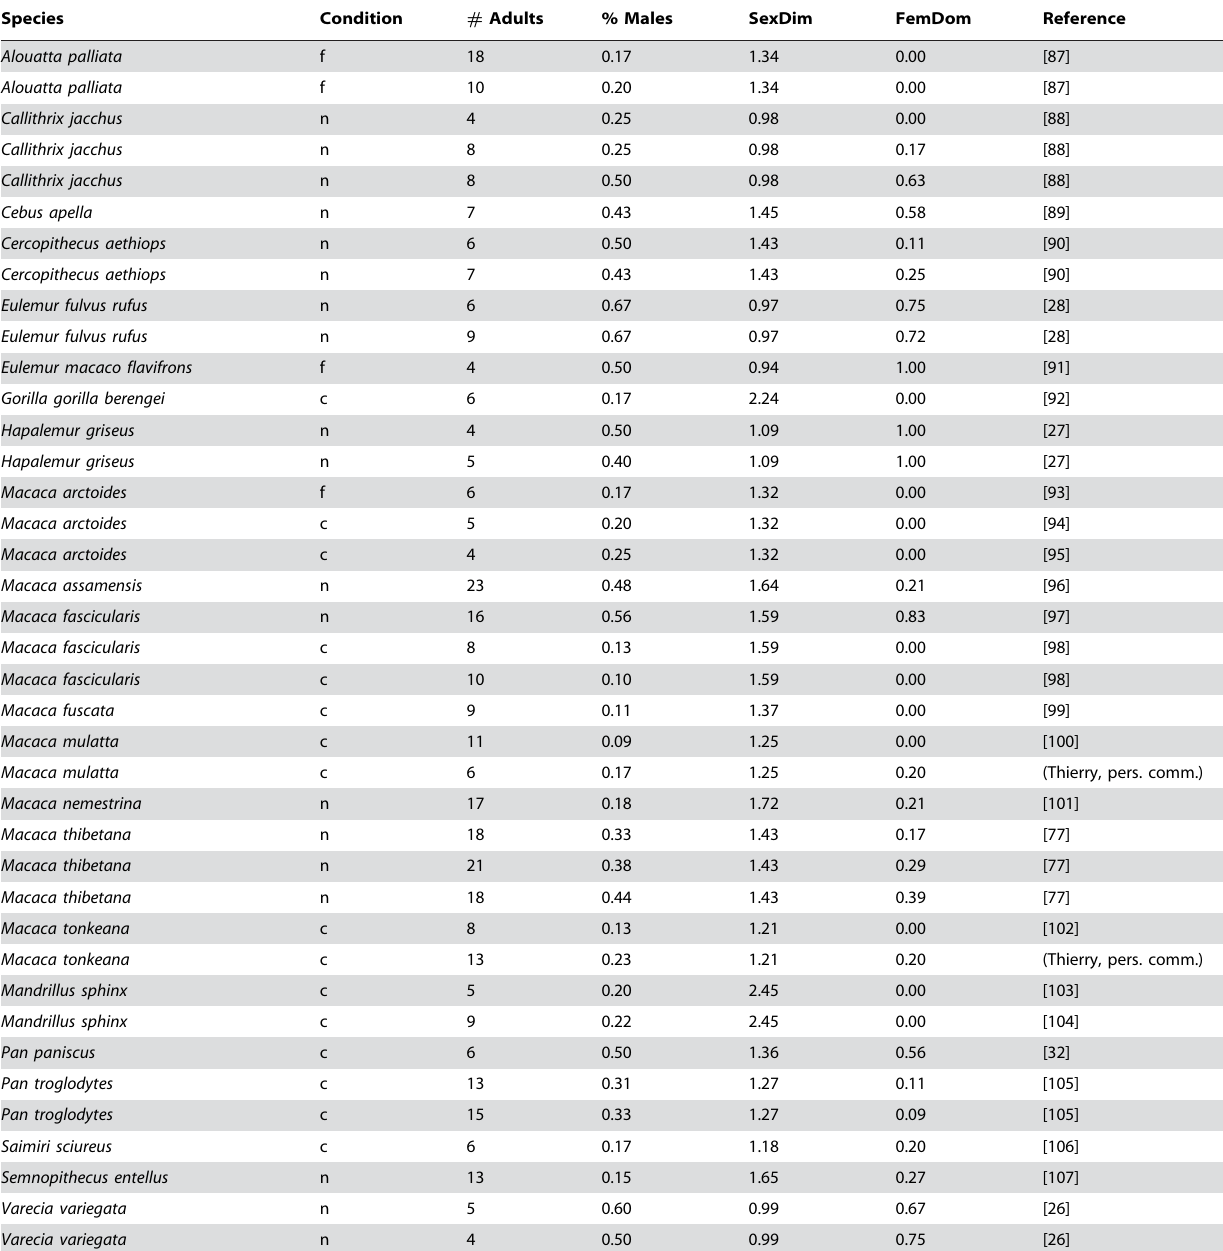
Table 4. Empirical